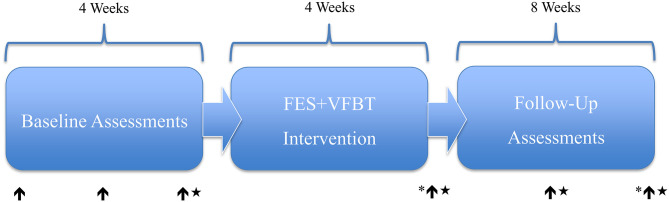
FES+ VFBT experimental timeline and assessment points. ↑ = Clinical Assessment. ★ = Biomechanical Assessment. * = Semi-Structured Interview.